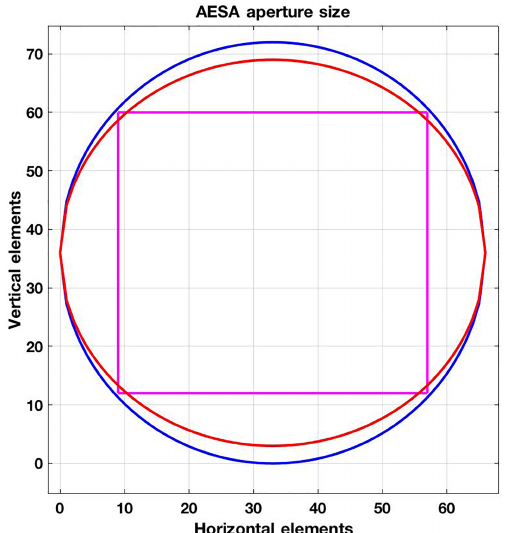
Figure 5. Elliptical, circular, and square phased array antenna aper-